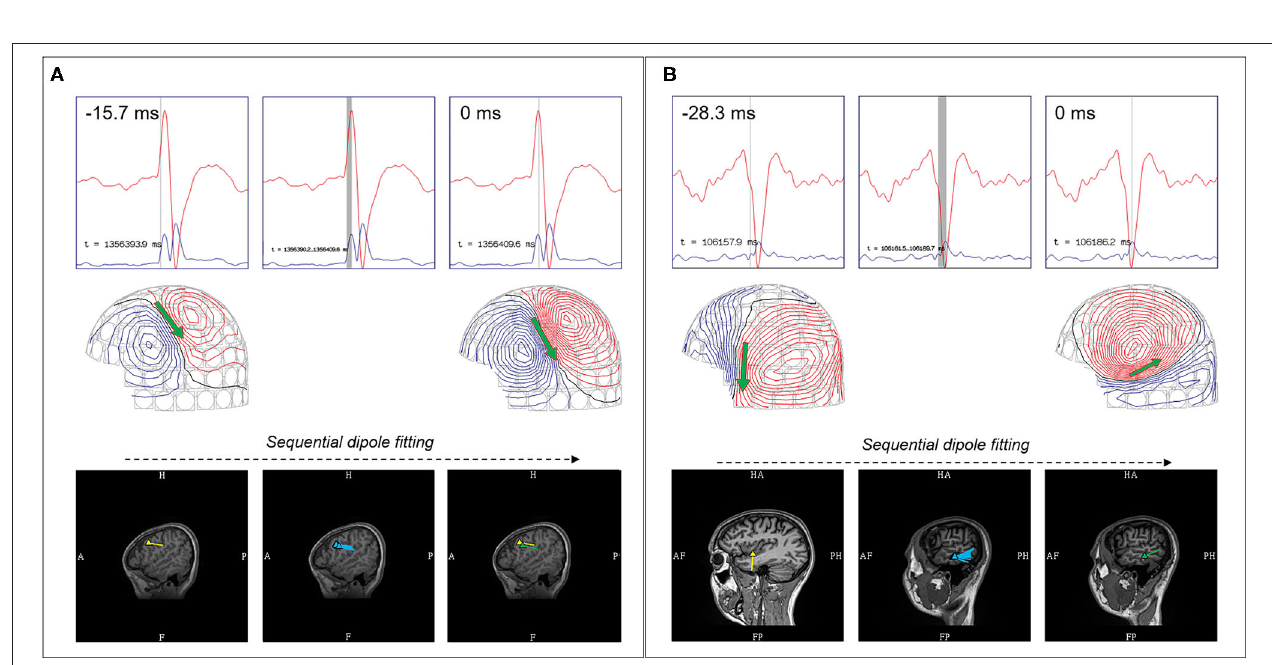
FIGURE 3 | Utilization of averaging to increase signal to noise for signal detection and modeling. (A) MEG-EEG recording that showed MEG signals (channel MEG1442, MEG2612) with a right temporal isofield that lacked an epileptiform morphology and EEG correlate. The averaged MEG signals showed a better epileptiform morphology and EEG correlate. (B) MEG-EEG recording that showed a small right hemispheric EEG signal with a comparatively less visible MEG correlate, having a right temporal isofield. Averaged EEG and MEG signals show an improved epileptiform morphology.